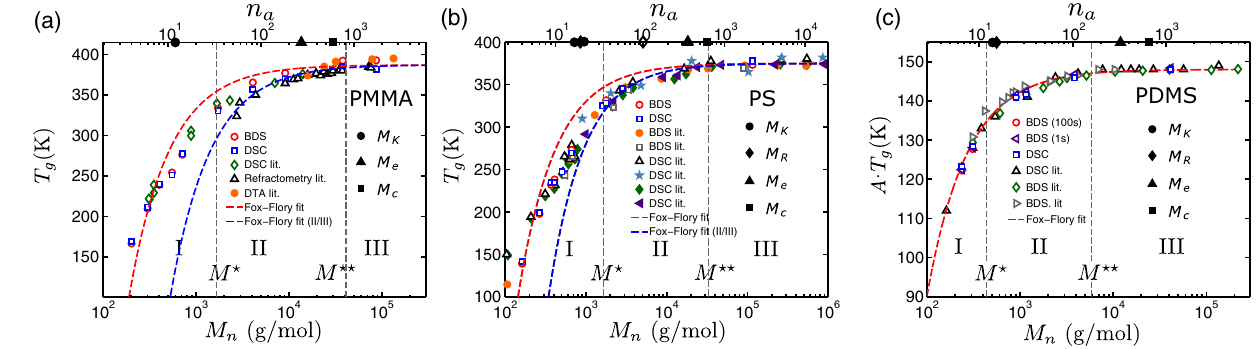
FIG. 10. T as a function of number-averaged molecular weight M g rheology are combined with literature data for PMMA [44,107,108], PS [12 – 14,109,110], and PDMS [13,47,111]. The absolute value of T M Þ can vary slightly between different studies because of the variation in experimental techniques, T g ð specification. For PDMS, these differences are more pronounced since T ≃ 200 K). Thus, a scaling factor A ∼ 1 – 1 . 03 is used to collapse different data sets onto AT PS ( Δ T g T determined from two different definitions, τ α ¼ 100 s and 1s, which slightly change T g symbols on the upper abscissa denote the Kuhn molecular weight (filled black circle; PMMA [112], PS [20]), the “ dynamical ” or Rouse molecular weight M (filled black diamond; PS and PDMS [20], diamond PS; using an alternative M R molecular weight M (filled black up-pointing triangle; PMMA [50], PS and PDMS [90]), and the critical molecular weight M e black square; PMMA [113], PS and PDMS [90]). Dashed lines are fits to the Fox-Flory expression T ranges for the fits. Here, n denotes the number of backbone atoms, and M ⋆ and M (cid:2)(cid:2) separate regimes I – III. a